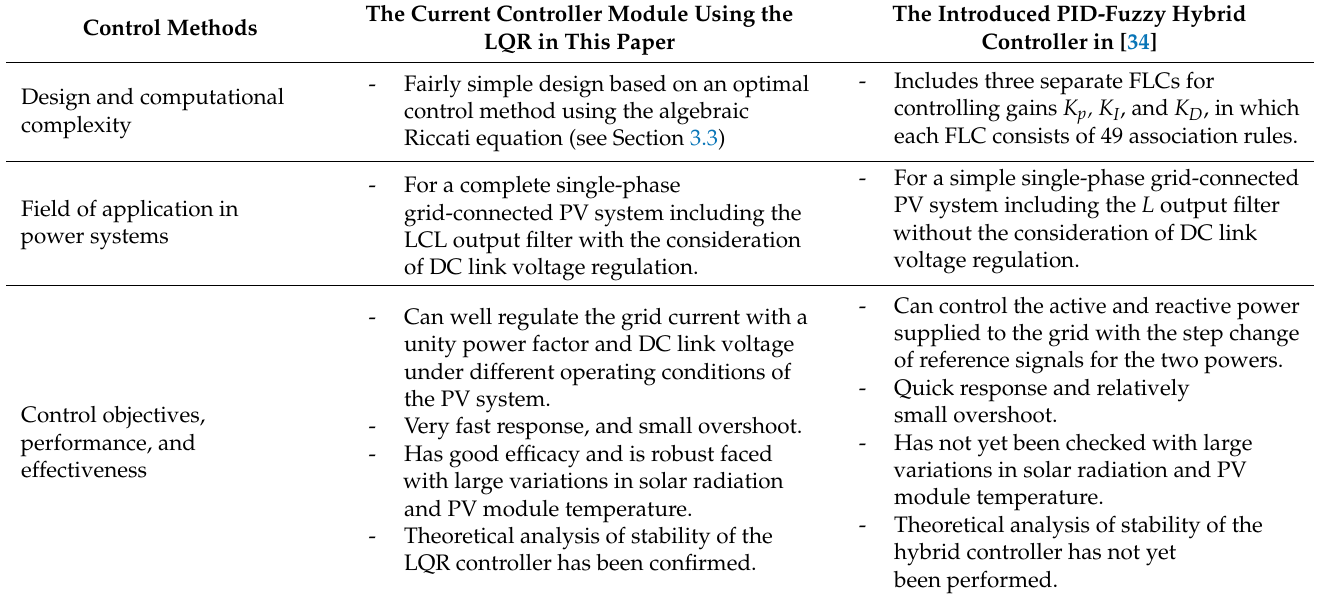
Table 6. Comparison between the proposed current controller module and the previously introduced PID-fuzzy controller in